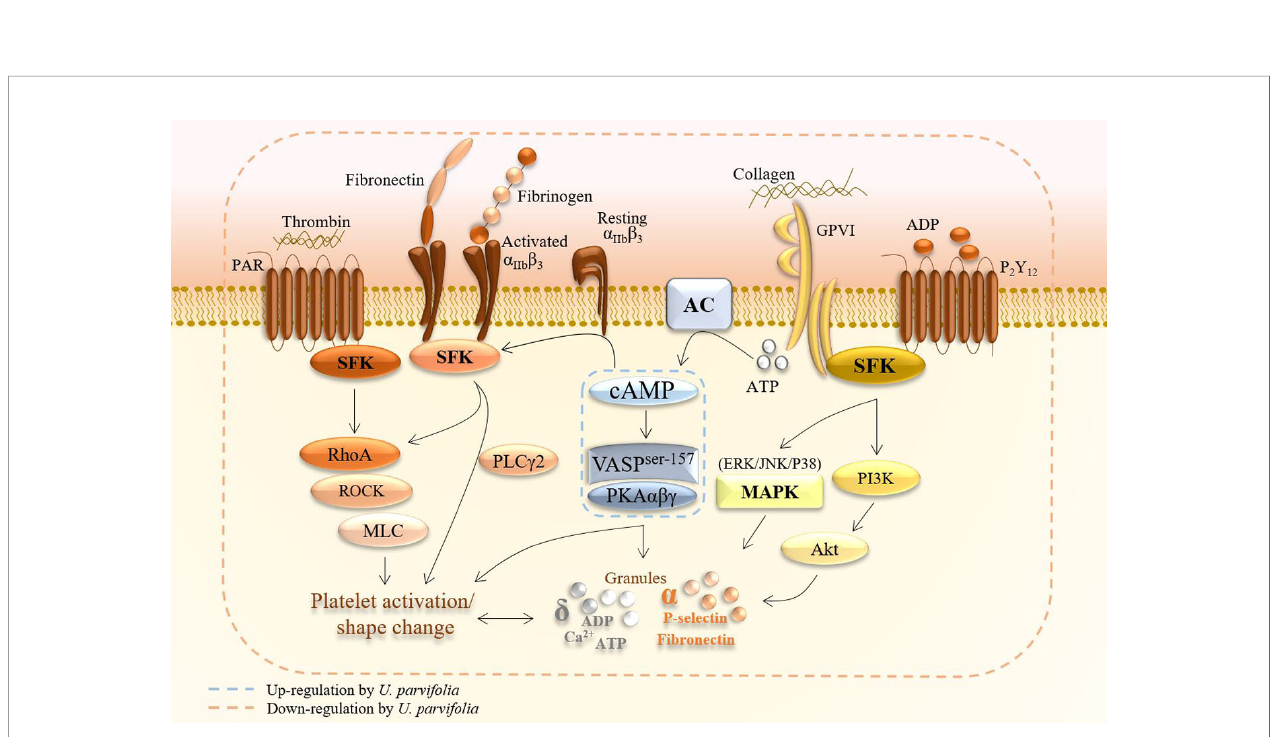
FIGURE 8 | A schematic summary of inhibitory effects of U. parvifolia extract on platelet intracellular signaling